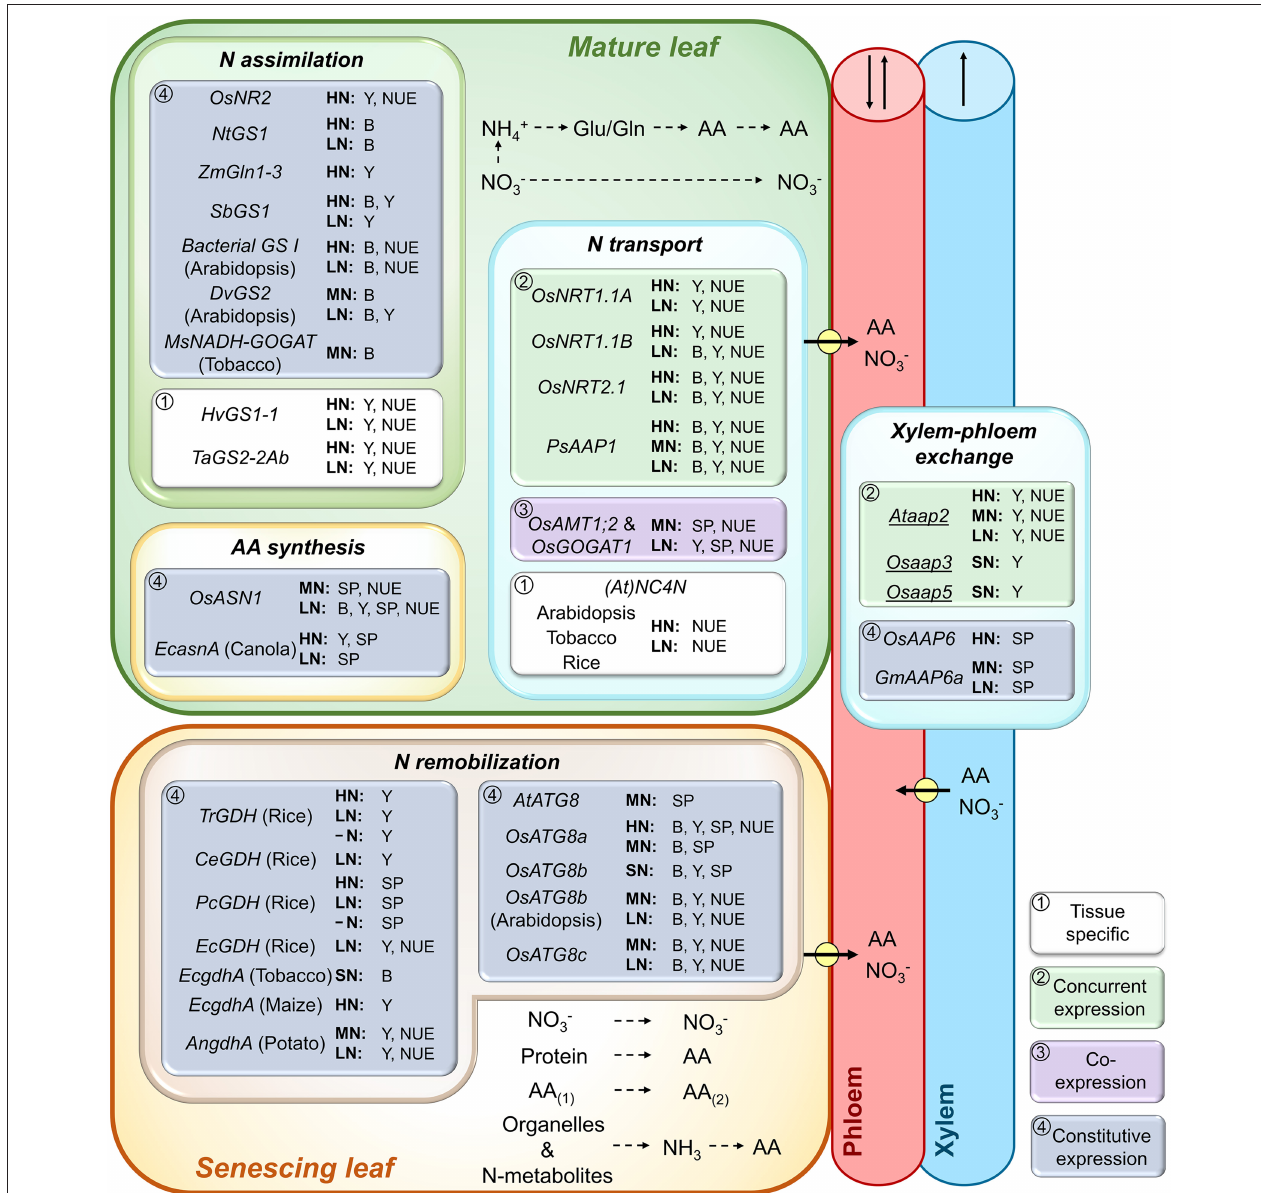
FIGURE 2 | Role of leaf N (re)assimilation and remobilization, amino acid (AA) synthesis and N transport processes in plant biomass, yield production, and N use efficiency. Genes expressed in mature, photosynthetically active leaves, and senescing leaves, respectively, were analyzed. Shown are genes that were successfully overexpressed ( UPPERCASE ) or repressed/knocked out ( lowercase and underlined ) and resulted in increased biomass (B), seed yield (Y), seed protein (SP), and/or plant N use efficiency (NUE) at varying N supply. As indicated by framed white, green, purple, or blue backgrounds, the transgenic strategies either used (1) tissue-specific gene manipulation, (2) concurrent expression of a particular gene in different source or sink tissues, (3) co-expression of two genes in root and shoot tissues ( OsAMT1;2 and OsGOGAT1 , Lee et al., 2020a), or (4) constitutive gene expression throughout the plant. Plants were grown under high (HN), moderate (MN), sufficient (SN; N supply was not specified), or low N (LN). For native/endogenous gene expression only gene names are provided, while the expression of non-native genes is indicated by the gene name and the common name of the transgenic plant species. Positive results were achieved for genes of a nitrate reductase ( OsNR2 , Gao et al., 2019b), glutamine synthetases ( NtGS1 , Oliveira et al., 2002; ZmGln1-3 , Martin et al., 2006; SbGS1 , Urriola and Rathore, 2015; bacterial GS I , Zhu et al., 2015; DvGS2 , Zhu et al., 2014), glutamate synthases ( MsNADH-GOGAT , Chichkova et al., 2001; OsGOGAT1 , Lee et al., 2020a), asparagine synthetases ( OsASN1 , Lee et al., 2020b; E. coli EcasnA , Seiffert et al., 2004), nitrate ( OsNRT1.1A , Wang et al., 2018b; ( At ) NC4N , a synthetic gene construct based on Arabidopsis gene sequences, Chen et al., 2020), and amino acid transporters ( PsAAP1 , Perchlik and Tegeder, 2017) as well as for glutamate dehydrogenases ( Trichurus sp . TrGDH , Du et al., 2019; C. ehrenbergii CeGDH , Zhou et al., 2015b; P. cystidiosus PcGDH , Zhou et al., 2014; E. cheralieri EcGDH , Tang et al., 2018; E. coli EcgdhA , Ameziane et al., 2000; Lightfoot et al., 2007; Aspergillus nidulans AngdhA , Egami et al., 2012) and autophagy-related proteins ( AtATG8 , Chen et al., 2019; OsATG8a , Yu et al., 2019; OsATG8b , Zhen et al., 2019a, Fan et al., 2020; OsATG8c , Zhen et al., 2019b). Pathways of N (re)assimilation, AA synthesis and conversion (AA (1) to AA (2) ), organelle and N metabolite degradation, as well as N phloem loading and xylem-phloem exchange (arrows with circle) are shown. Arrows in xylem and phloem indicate possible directions of translocation. For additional information see manuscript